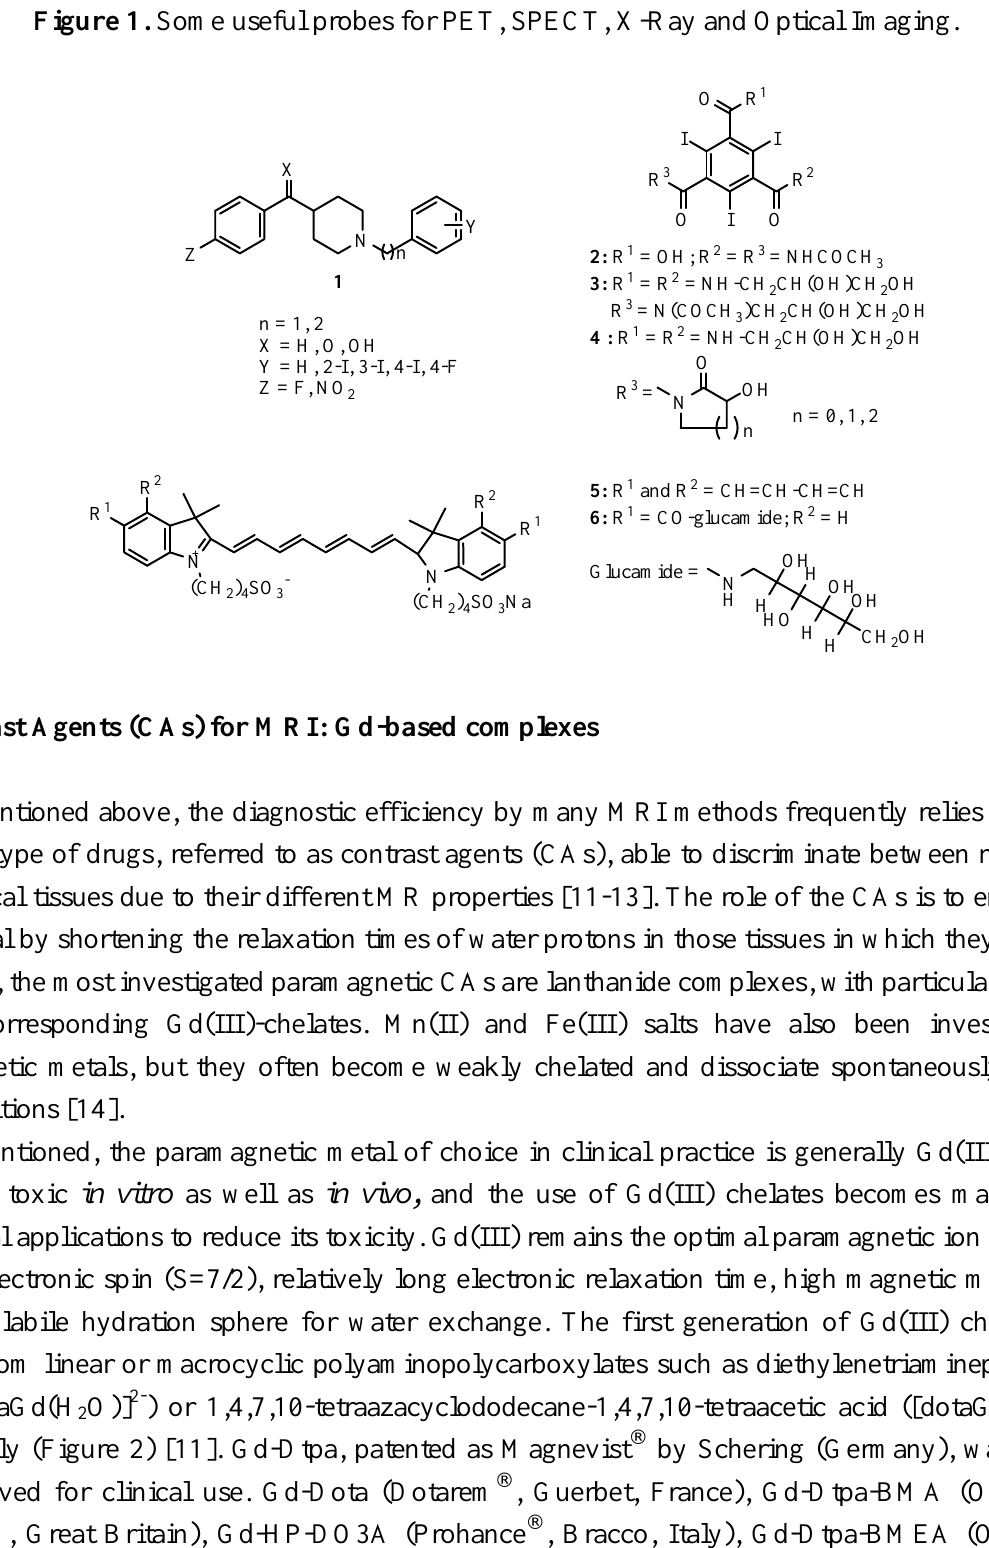
Figure 1. Some useful probes for PET, SPECT, X-Ray and Optical